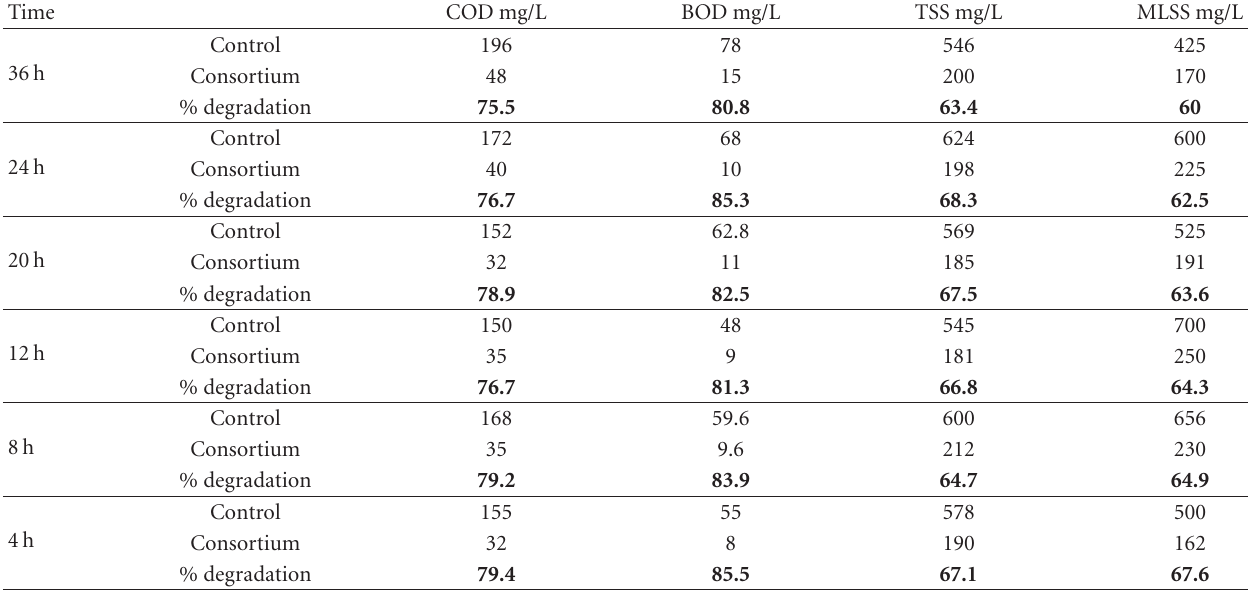
Table 5: Showing the reduction in time thereby reducing the COD mg/L, BOD mg/L, TSS mg/L, and MLSS mg/L by using consortium 13.